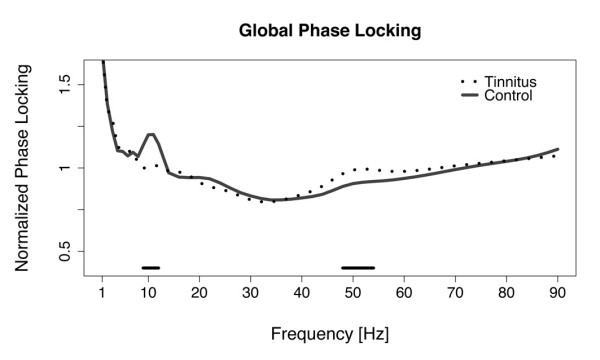
Phase locking averaged over all connections. Differences between the tinnitus and the control group were significant in the alpha 9–12 Hz and the gamma 48–54 Hz frequency range. Asterisks mark significant frequency bins after Bonferroni correction.